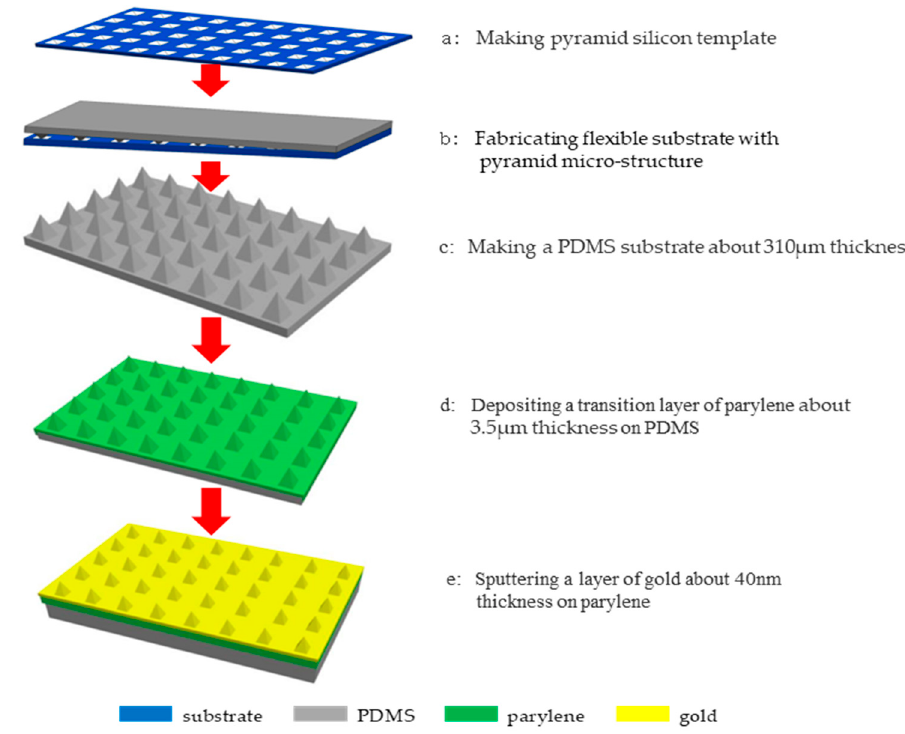
Figure 3. Flow chart of flexible electrode fabrication.